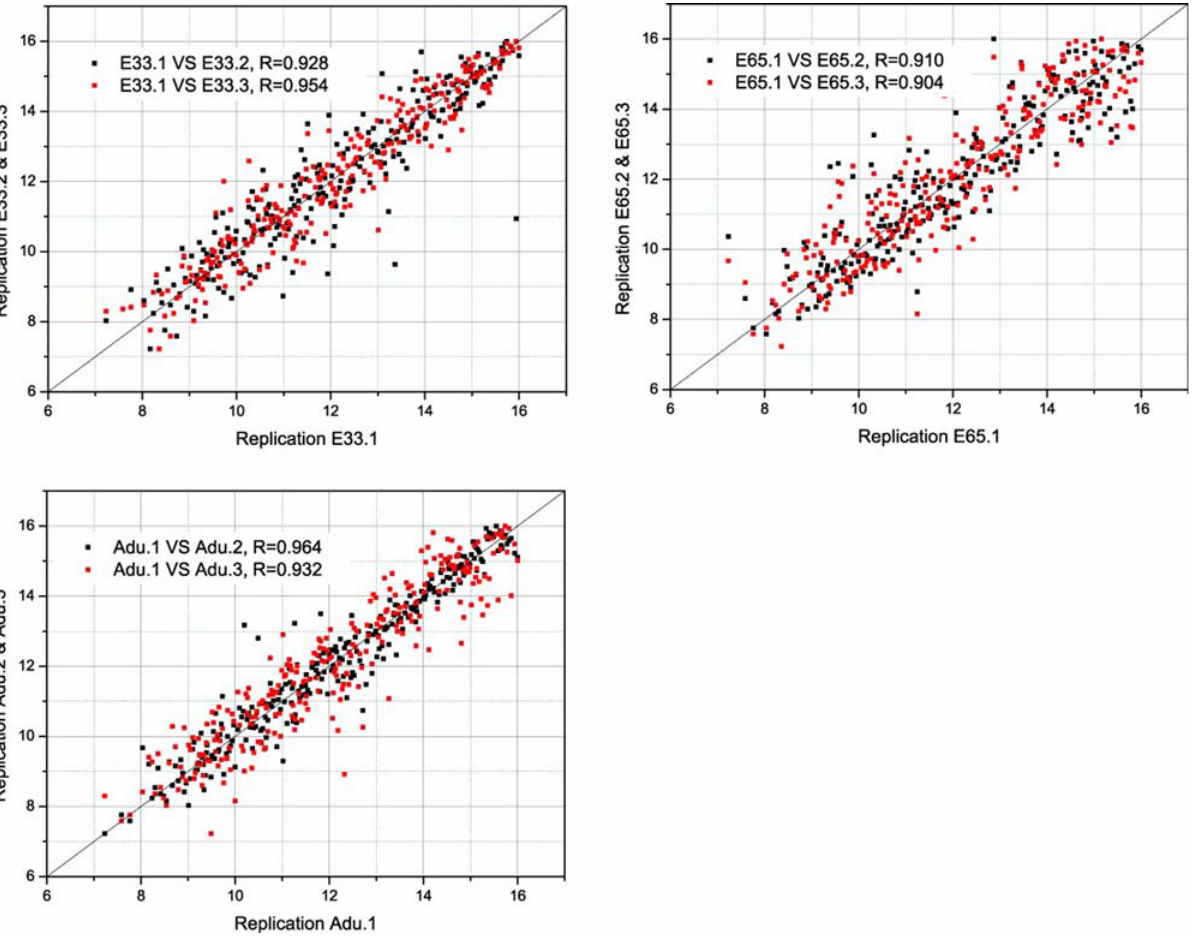
Figure 1. Reproducibility of the microarray experiments. We examined the miRNA expression in three developmental stages of skeletal muscle (E33, E65 and Adu). Samples from each stage were isolated in triplicate and hybridized to the microarray. Scatter plots demonstrate the pair- wise comparison between each two sets of triplicates. The R represents the Spearman correlation coefficient.